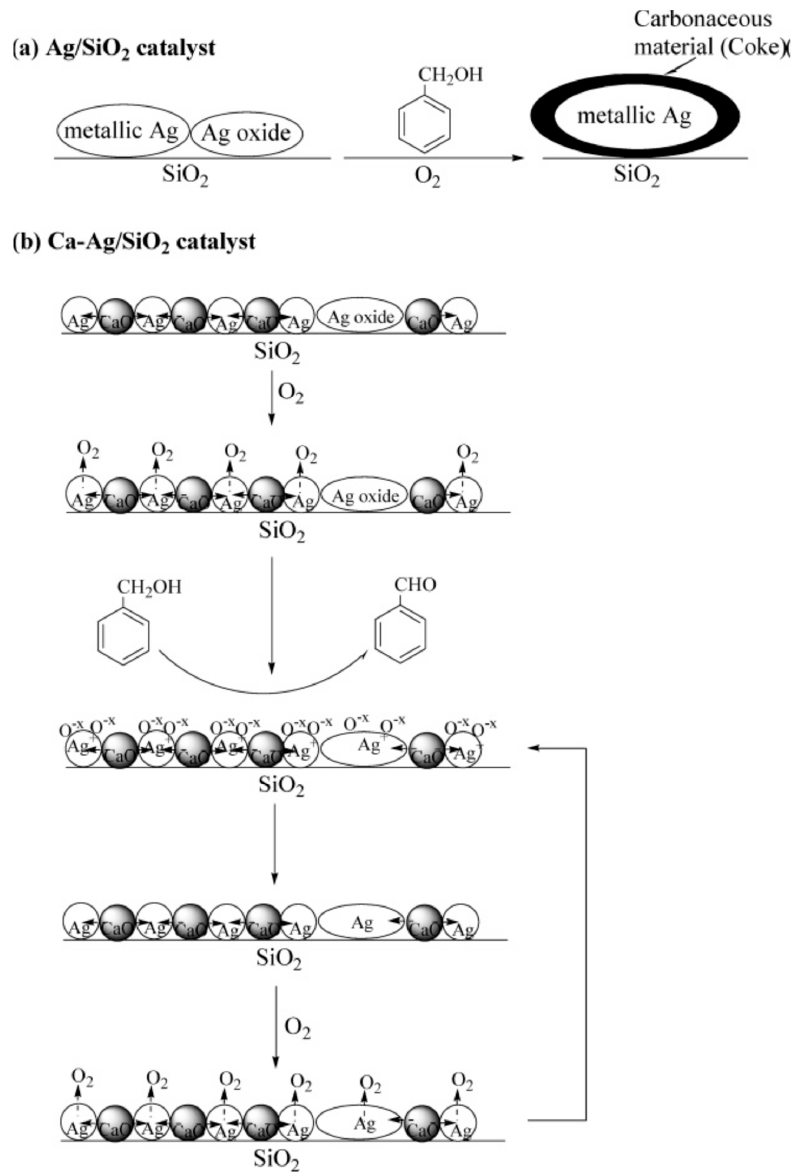
Figure 5. Reprinted with permission from reference [76]. Copyright 2006 Elsevier.